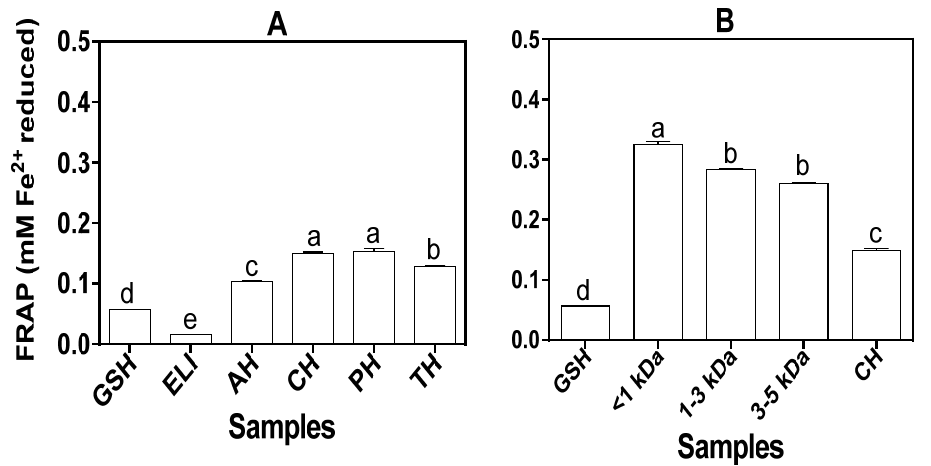
Figure 3. ( A ). Ferric reducing antioxidant power of glutathione (GSH), eggplant leaf protein isolate (ELI) and hydrolysates: alcalase (AH), chymotrypsin (CH), pepsin (PH) and trypsin (TH). Hy- drolysates. ( B ). FRAP of chymotrypsin hydrolysate (CH) and the ultrafiltration peptide fractions. Values are mean ± standard deviation of three determinations. Bars with different letters (a–e) on the same layout are significantly different ( p ≤